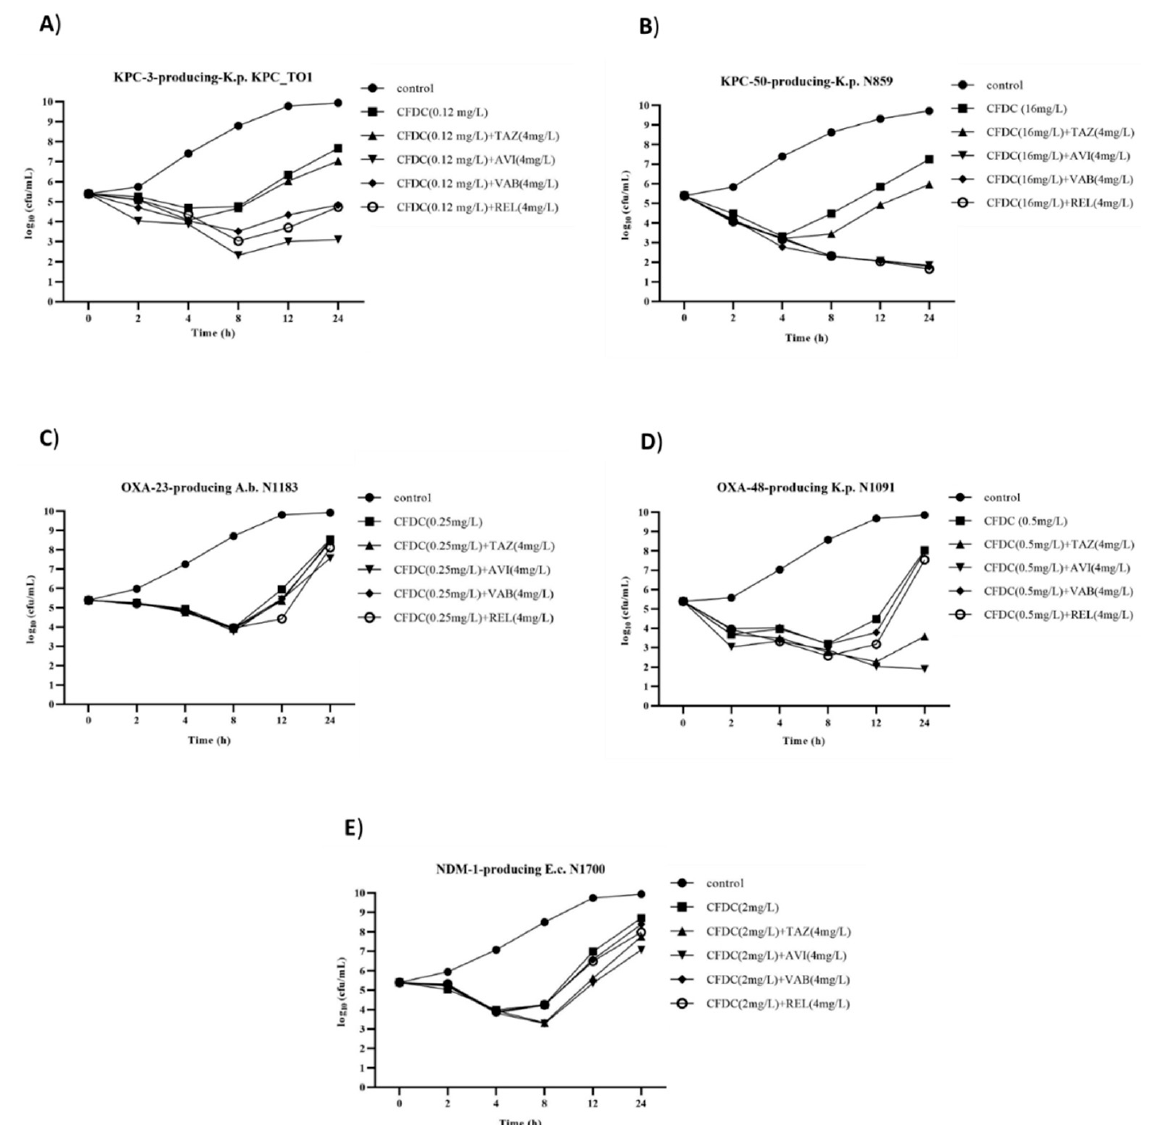
Figure 1. Time–kill curves of cefiderocol alone and combined with tazobactam, avibactam, vaborbactam and relebactam against KPC_T01 carrying bla KPC-3 ( A ), N859 carrying bla KPC-50 ( B ), N1183 carrying bla OXA-23 ( C ), N1091 carrying bla OXA-48 ( D ) and N1700 carrying bla NDM-1 ( E ). Data are presented as arithmetic means. Differences ≤ 0.5 log 10 at each time point were observed. Time–kill curves of β -lactamase inhibitors alone against the five isolates tested overlapped with the positive control (differences ≤ 0.5 log 10 at each time point) and were not included in the graphs.